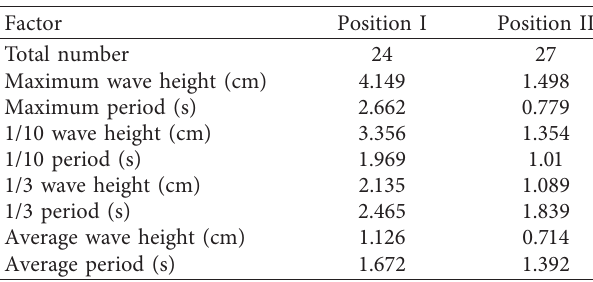
Table 5: Statistics regarding wave elements at positions I and II. Factor Position I Position II Total number 24